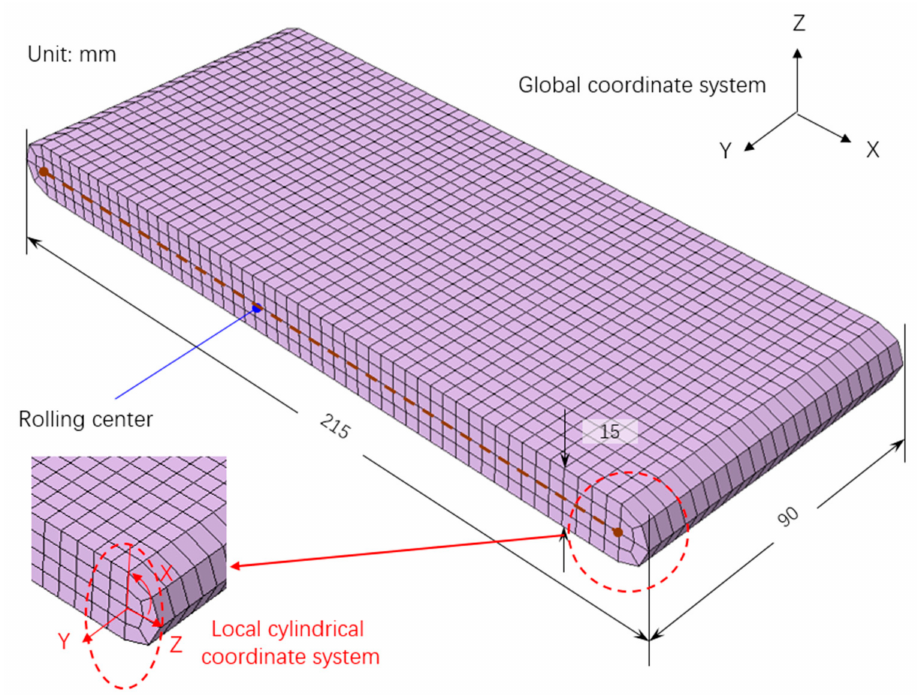
Figure 4. Jellyroll model and the coordinate system